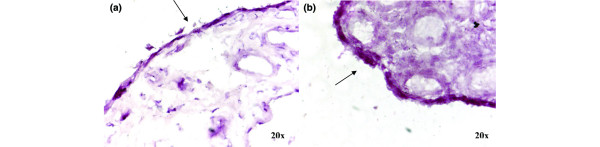
Haematoxylin and eosin staining on healthy and arthritic synovial tissue. Haematoxylin and eosin staining was performed on synovial biopsies from (a) healthy subjects and (b) Rheumatoid arthritis patients. Arrows indicate synovial lining.